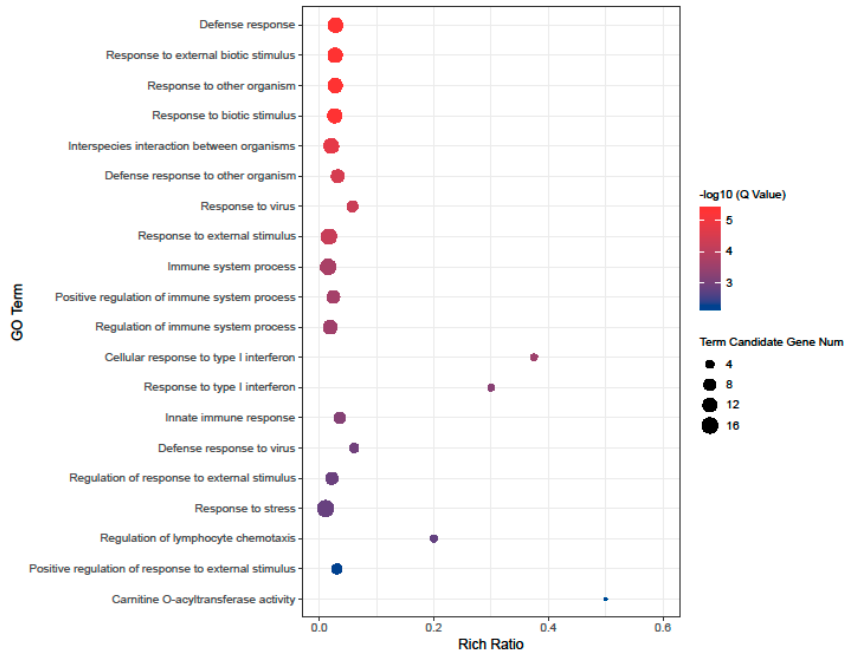
Figure 3. GO enrichment analysis of upregulated DEGs in the age 11 group.